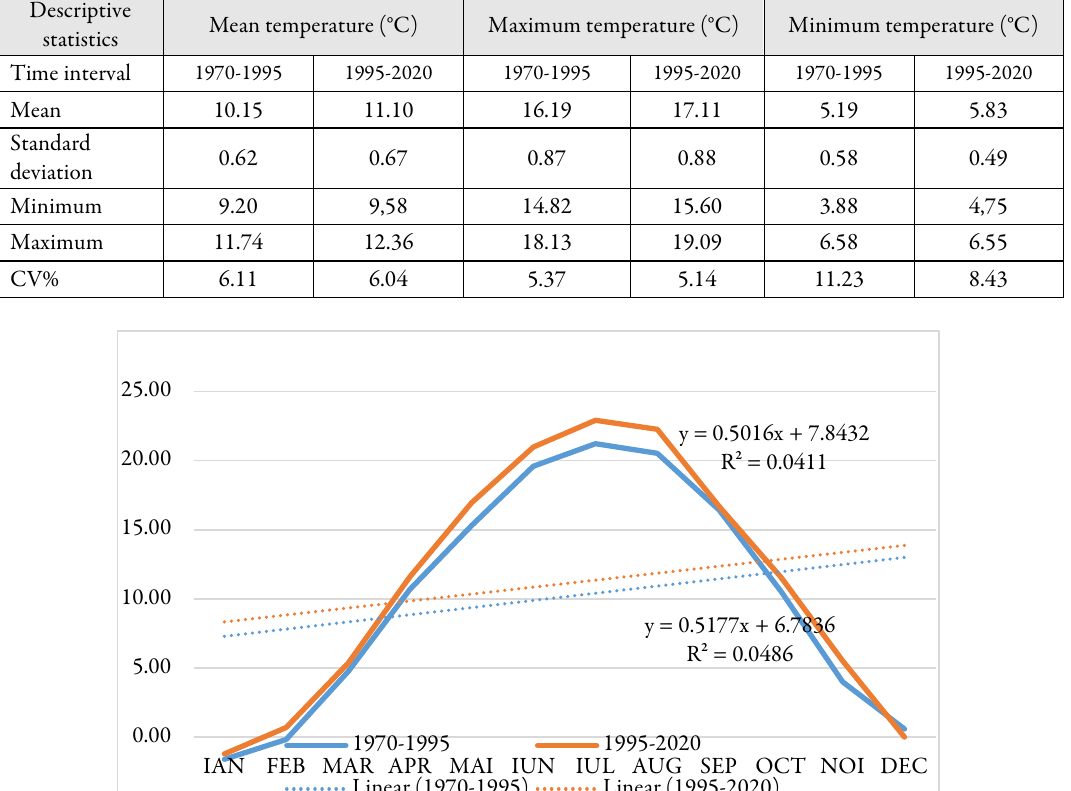
Table 2. Variation of average annual temperatures over the analysed time intervals in Găești area, South-